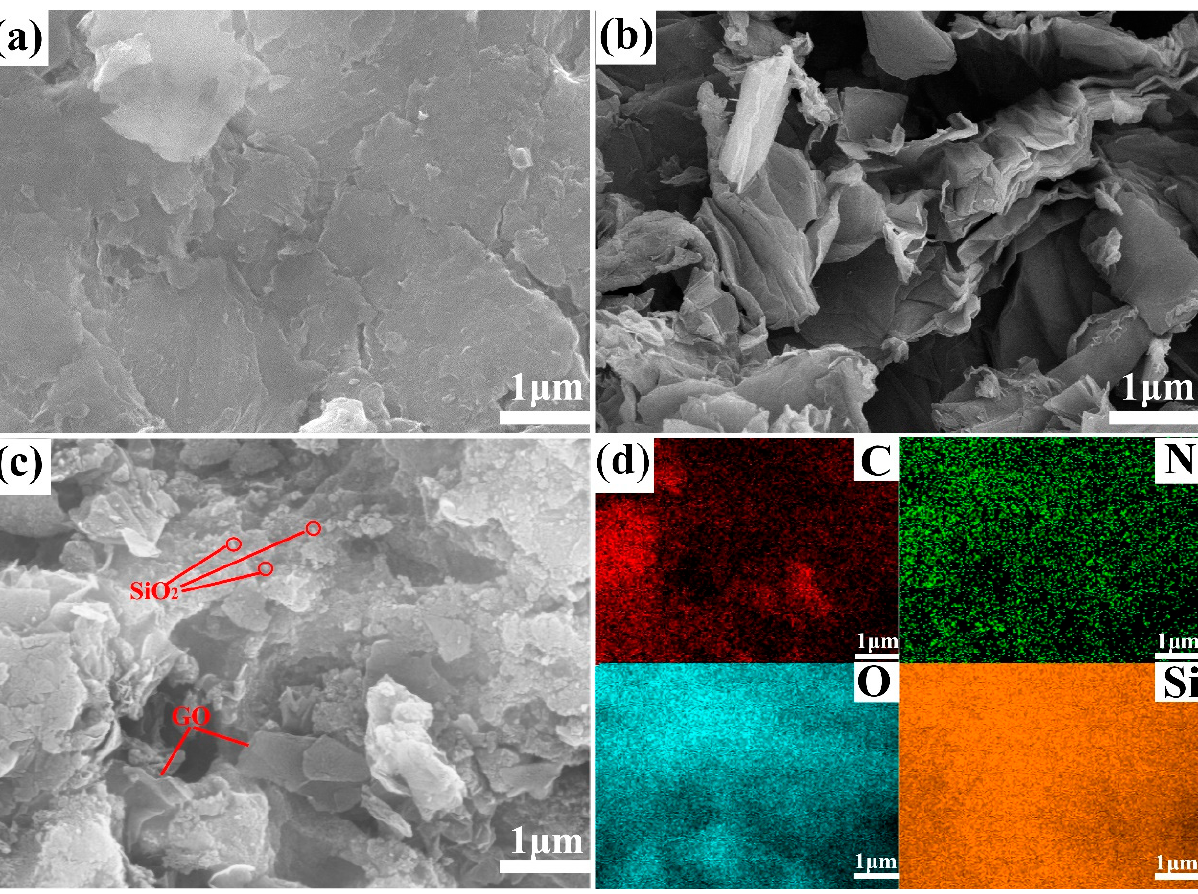
Figure 4. SEM image of ( a ) GO, ( b ) DDM − GO, ( c ) DDM − GO@SiO 2 ; ( d ) EDS mapping spectra of DDM − GO@SiO 2 .